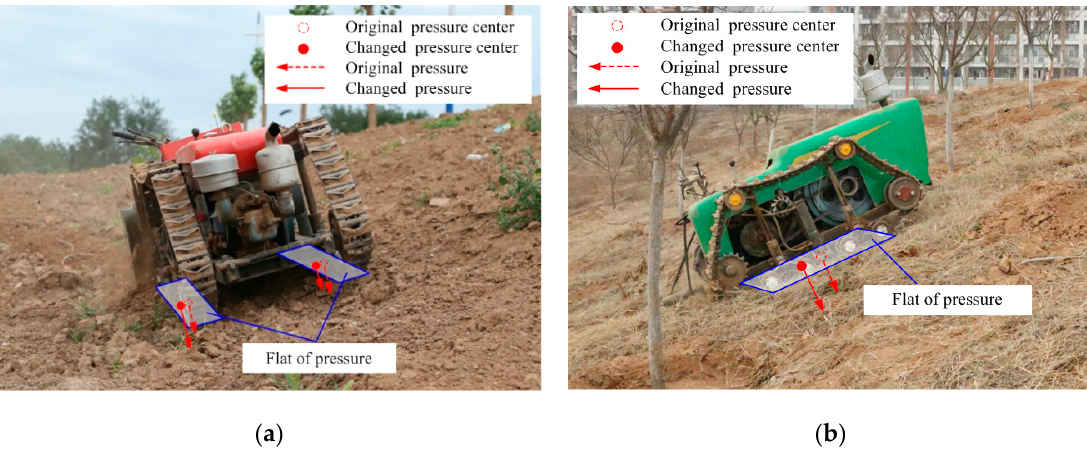
Figure 1. Sketch diagram of pressure center change of HMT. ( a ) Running along contour line; ( b ) Climbing longitudinal- ly.